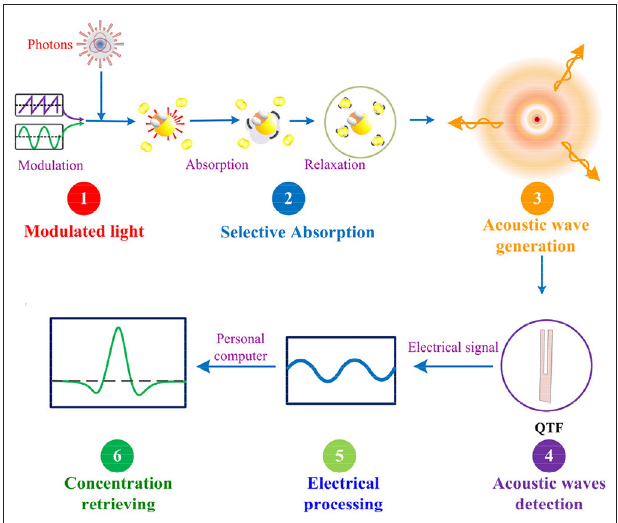
FIGURE 1 | Schematic diagram of photoacoustic spectroscopy.